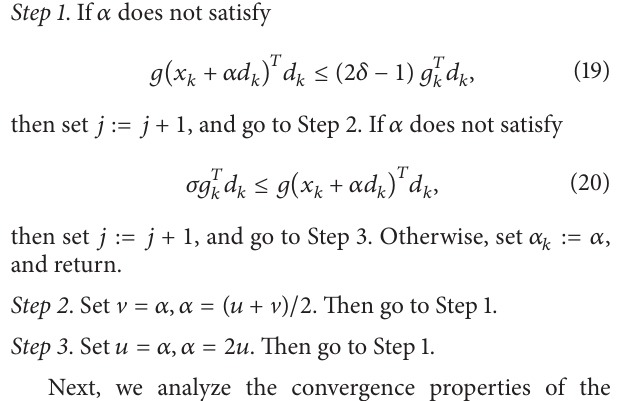
Algorithm 6. Step 0 . Set 𝑢 = 0 and V = +∞ . Choose 𝛼 > 0